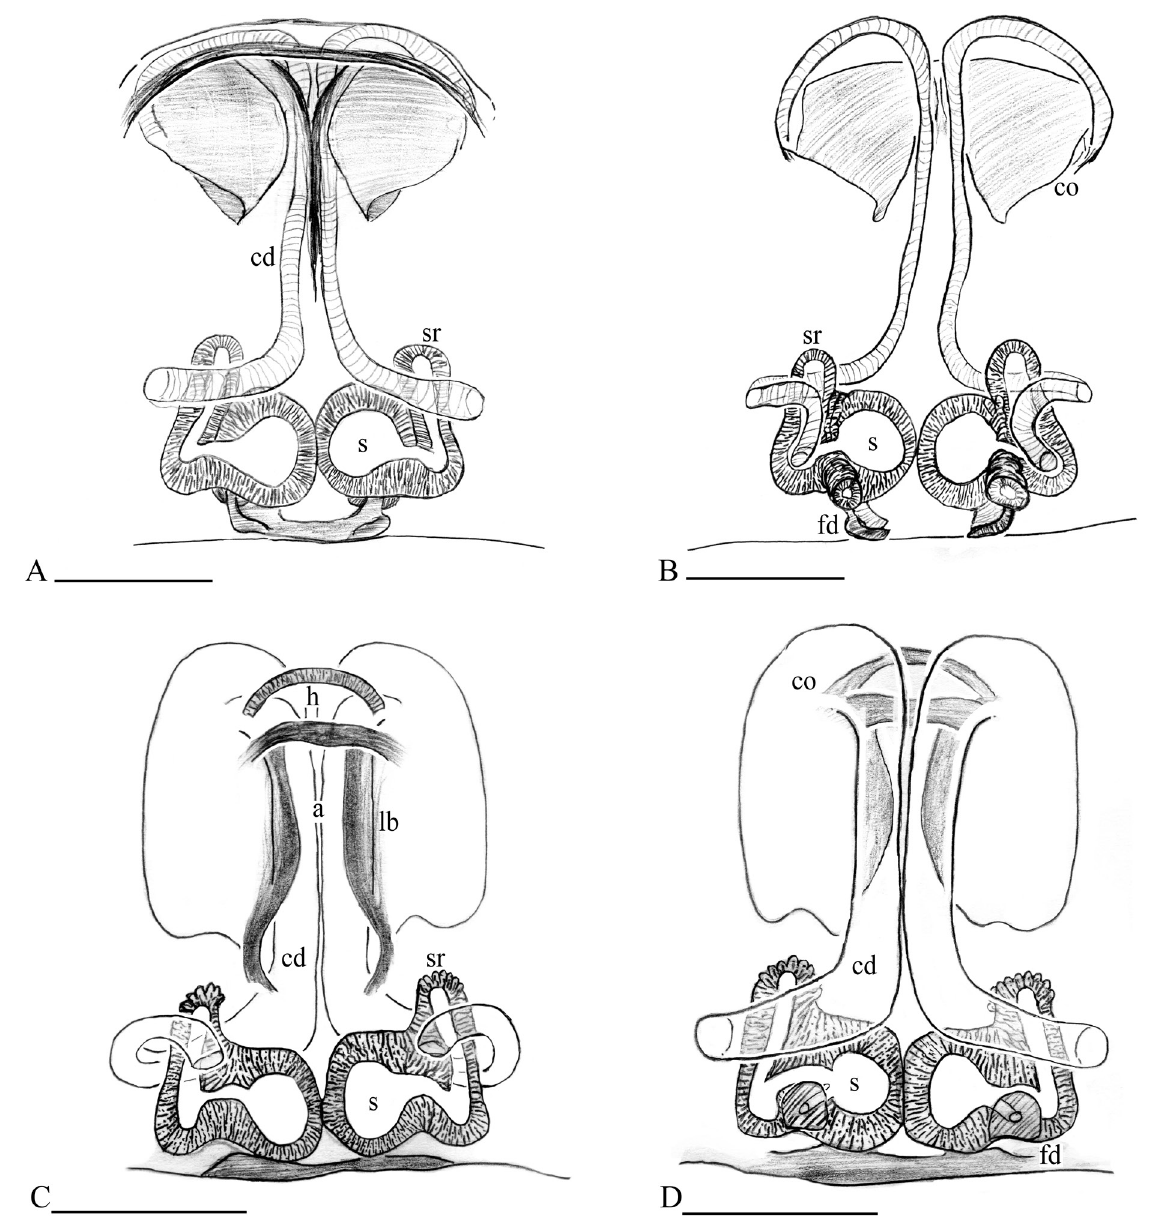
Fig. 44. Anyphaena spp. A–B . A. salgueiroi sp. nov., holotype, ♀ (CNAN-T01537). A . Epigynum, ventral view. B . Epigynum, dorsal view. – C–D . A. ibarrai sp. nov., holotype, ♀ (CNAN-T01528). C . Epigynum, ventral view. D . Epigynum, dorsal view. Scale bars: 0.2